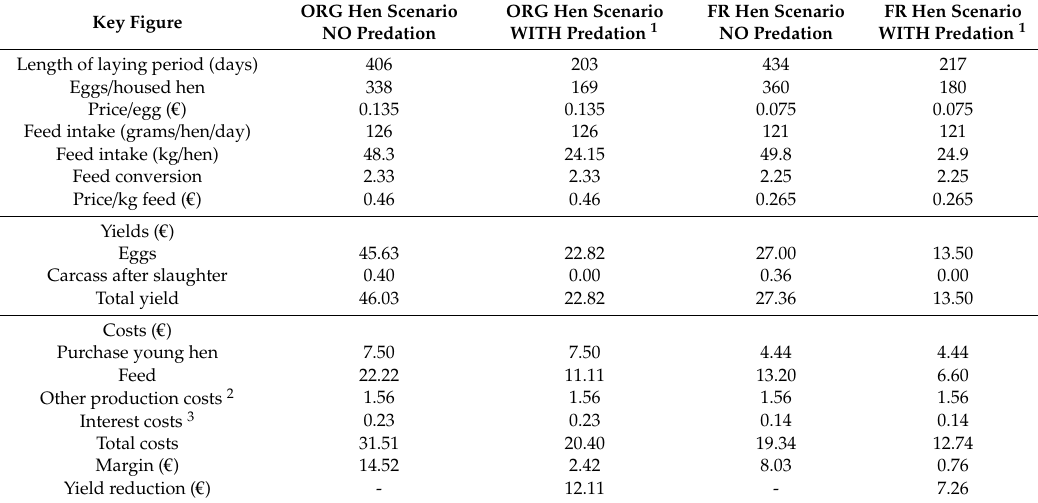
Table 8. Financial result (margin) per hen, under scenarios with and without predation, both for an organic (ORG) and a free-range (FR) production